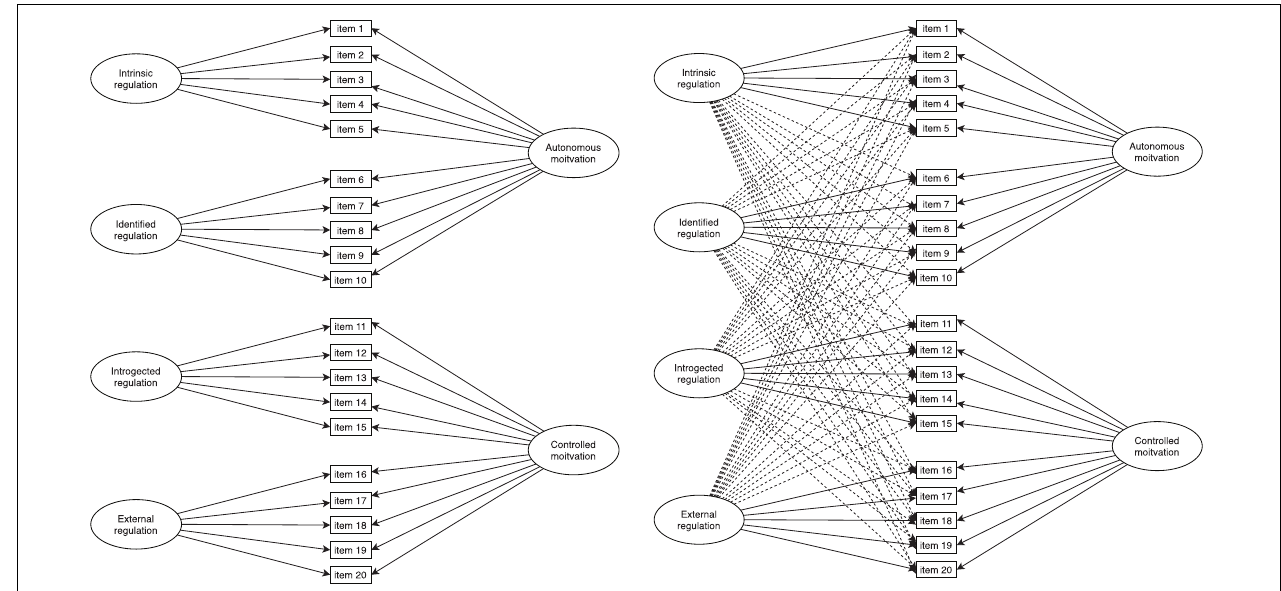
FIGURE 1 | Visual representation of the bifactor CFA (on the left) and bifactor ESEM (on the